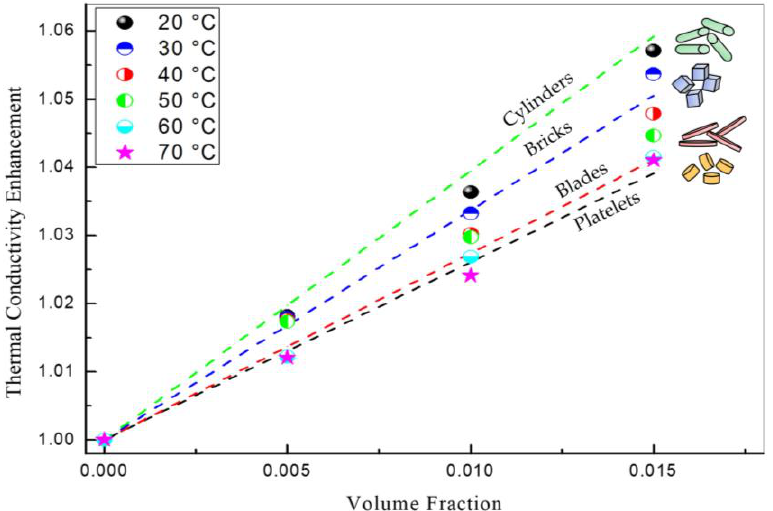
Figure 11. Thermal conductivity enhancement vs. volume fraction. The different shapes are outlined from the TEM microscopy of the powder shown in Figure 5. In this figure, brick, cylinders, blades, and platelets of different sizes are displayed. Table 1. Contribution of particle shape effect and surface resistance to the thermal conductivity of ZnO powder in 40:60 PG/W.